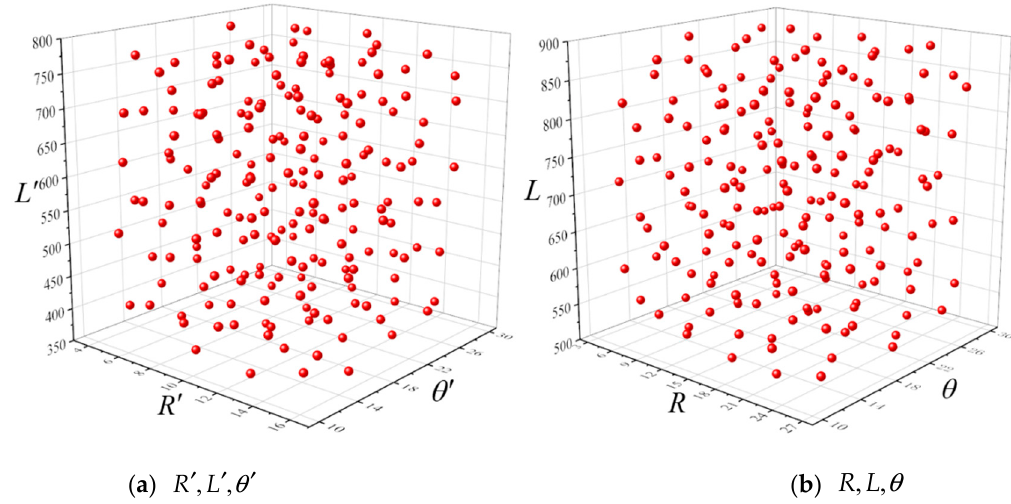
Figure 13. Schematic diagram of the sampling points based on OPLHS.